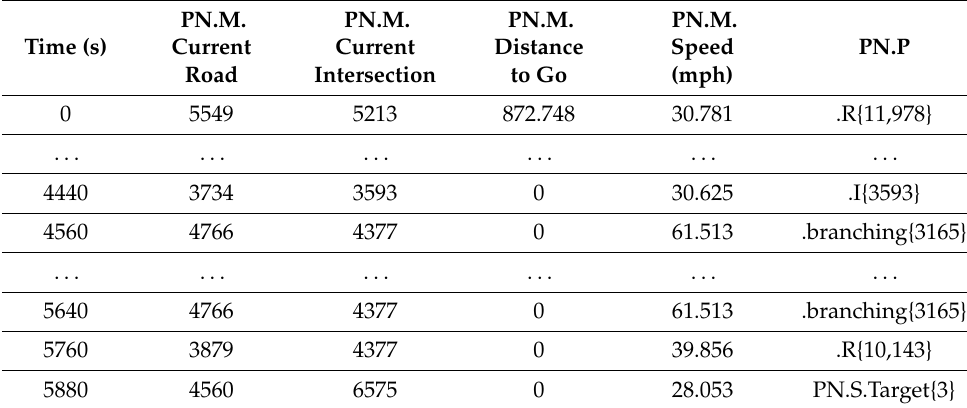
Table 1. Marking for a person (P.ID = 114,359).